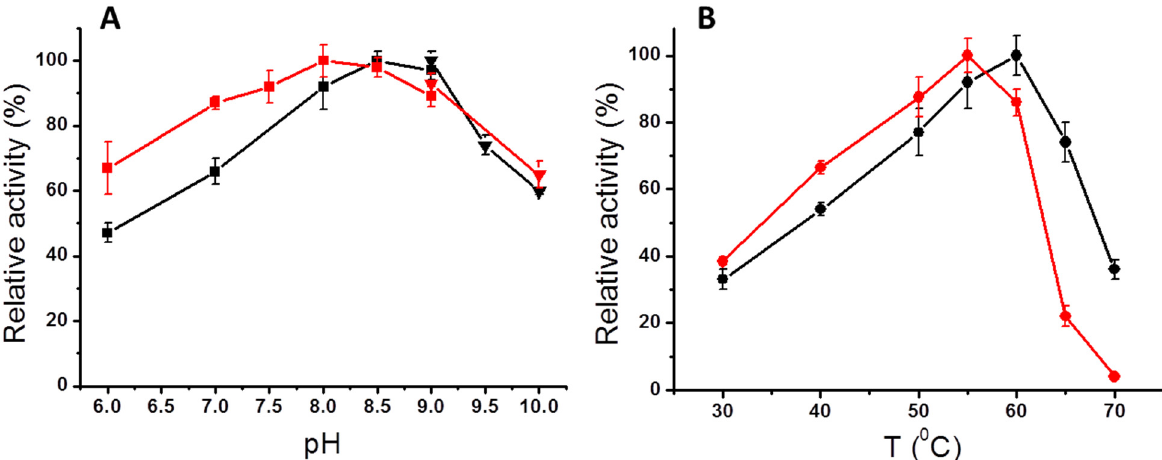
Figure 2. pH- and temperature dependences of AmicoTA activity in the overall transamination reactions between D-alanine and α -ketoglutarate (black) and D-glutamate and pyruvate (red); 100% corresponds to 0.62 ± 0.05 U/mg (( A ), black), 0.26 ± 0.01 U/mg (( A ), red), 1.55 ± 0.05 U/mg (( B ), black) and 0.60 ± 0.03 U/mg (( B ), red). Black/red squares: mixed buffer 25 mM Tris-HCl and 25 mM K-phosphate, pH 6–9. Black/red triangles: 50 mM CHES buffer, pH 9–10. Bars mean standard deviation. Table 4. Kinetic parameters of the overall transamination reactions between D-alanine and α - ketoglutarate (in 50 mM CHES buffer, pH 9.0) and the reverse reaction between D-glutamate and pyruvate (in 50 mM K-phosphate buffer, pH 8.0), catalyzed by AmicoTA, at 60 ◦ C.